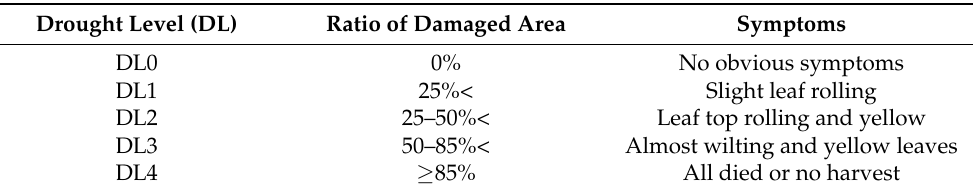
Table 2. Definition of the drought level (DL) assessment.